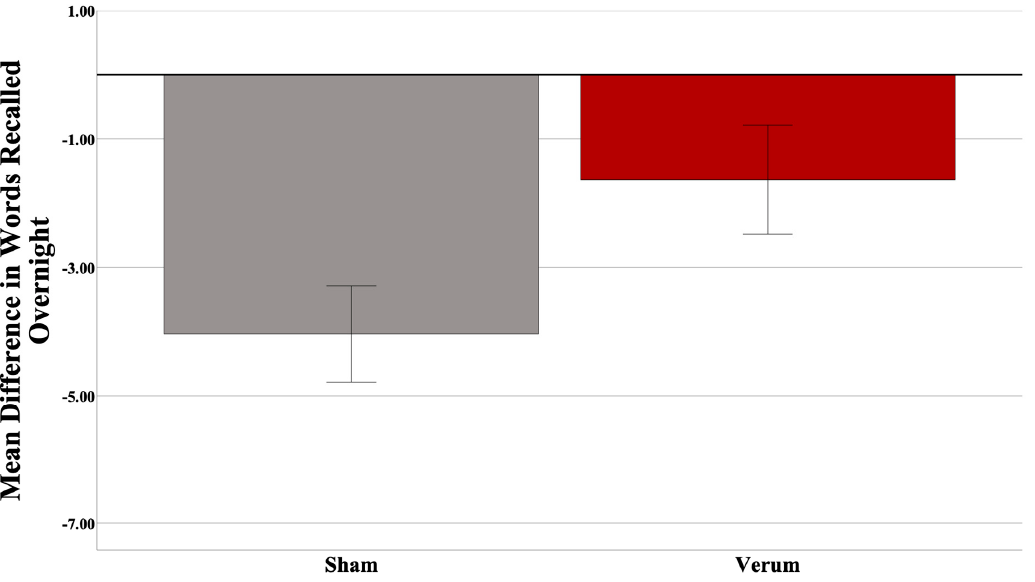
Figure 3. Significant behavioral effect ( p = 0.04297) for verum tACS overall. Error bars = +/ − 1 SEM.